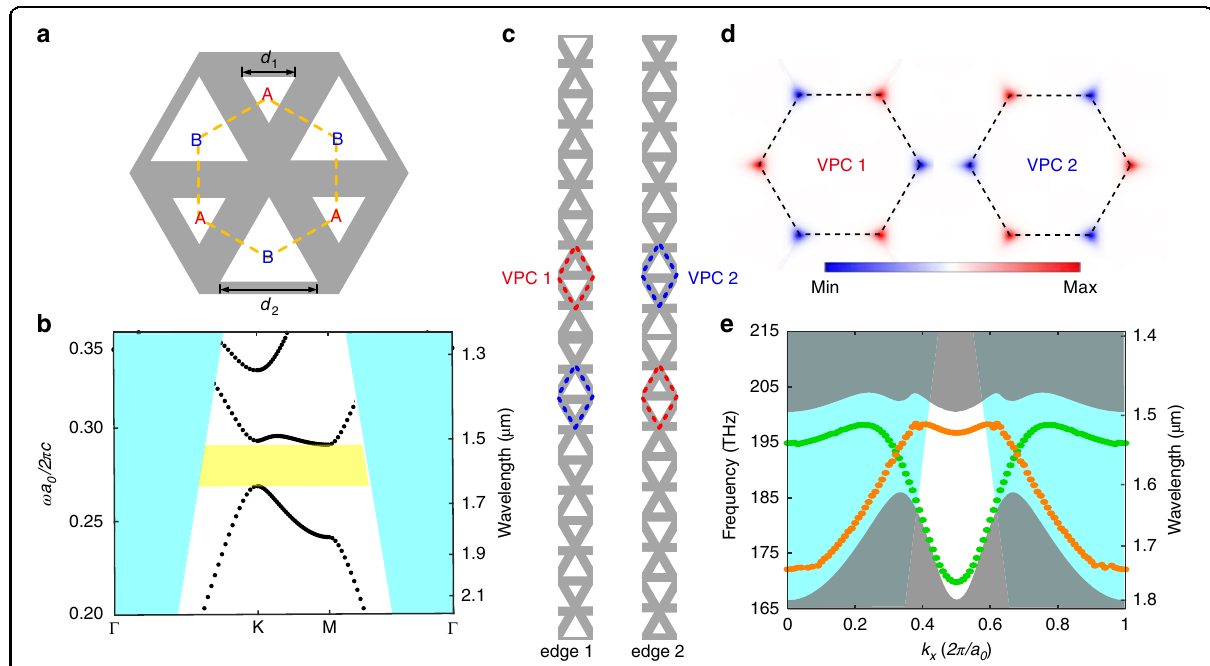
Fig. 1 Topological VPC and its bulk band diagram. a The dashed hexagon in the schematic presents the unit cell of the VPC slab ( d 1 = 122 nm, d 2 = 295 nm). The lattice constant a 0 = 433 nm. b Bulk band for both VPC1 and VPC2, where the TE-like polarization bandgap lies between 1500 and 1650 nm. In the fi rst Brillouin zone, Γ , K and M denote the high-symmetry points. c Structures for edge 1 and edge 2 in one period along the x- direction, with grey and white regions representing silicon and silica, respectively. The unit cells of VPC1 and VPC2 are outlined with red dashed lines and blue dashed lines, respectively. d Berry curvature distribution of the TE 1 band for VPC1 (left) and VPC2 (right). e Edge dispersion of the two edge states supported by edge 1 (green) and edge 2 (orange). The projected bulk band is grey colour. In b and e , the region above the light cone is cyan shows the dispersion of edge states localized at edge 1 (green curve) and edge 2 (orange curve), named edge state 1 and edge state 2, respectively. The group velocities of the two edge states are almost constant around the val- leys, so the effects of the group-velocity dispersion can be ignored for these states. The difference between the relative positions of valleys and light lines in Fig. 1b, e comes from band folding (for details, see Supplementary Note 1).